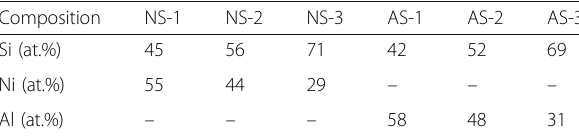
Table 1 Nomenclature for Ni silicide or Al silicide nanoparticle- embedded Si thin films